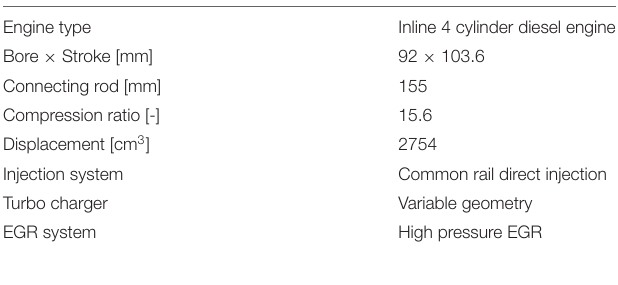
TABLE 4 | The engine specifications for the DFE combustion control model.